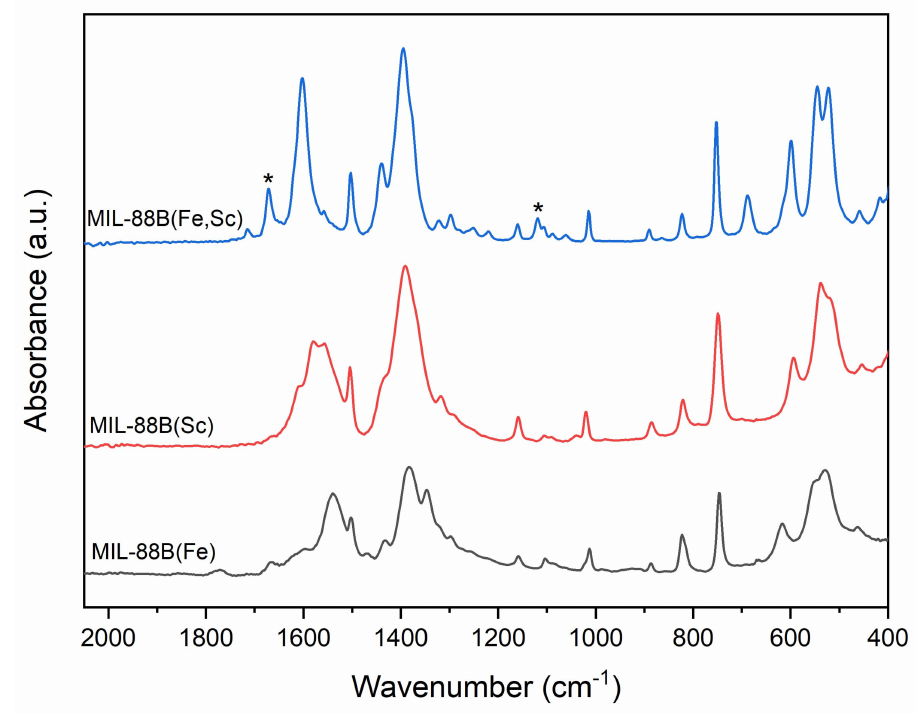
Figure 8. Infrared spectra of MIL-88B materials. The features labelled * are assigned as due to uncoordinated carboxylic acid